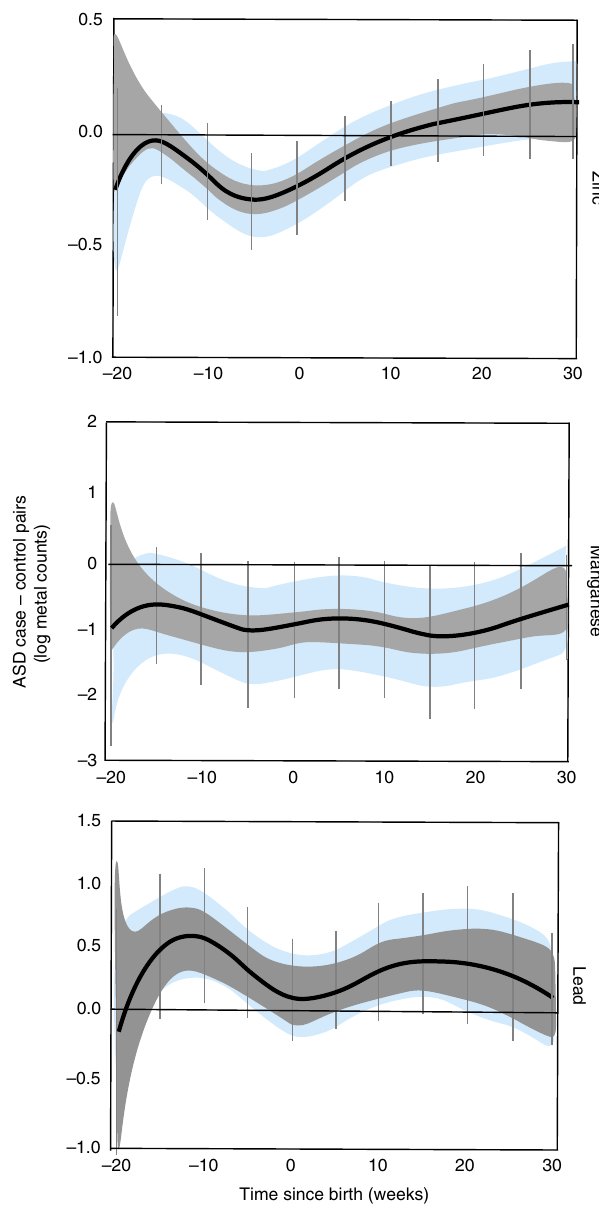
Figure 4 | Developmental periods of maximal metal dysregulation in ASD discordant versus non-ASD control twin pairs. DLMs for zinc, manganese and lead. Black line represents mean of paired differences in metal levels between twins discordant for ASD (3 MZ; 4 DZ) and non-ASD control pairs (9 MZ; 10 DZ). Data are shown as 95% bands unadjusted (grey band) and adjusted (blue band) for intra-twin correlations. Grey vertical lines are Holm–Bonferroni corrected family-wise 95% CIs for 11 comparisons (every fifth week). Values above zero represent increased levels in ASD cases compared to their non-ASD sibling after taking into account average difference in control twins. A critical window is defined as an area of the DLM adjusted for intra-twin correlations (blue band) that does not include zero. Models were adjusted for sex, zygosity, gestational age, the average birth weight of the twin pairs, and the s.d. of the birth weight in the twin pairs.